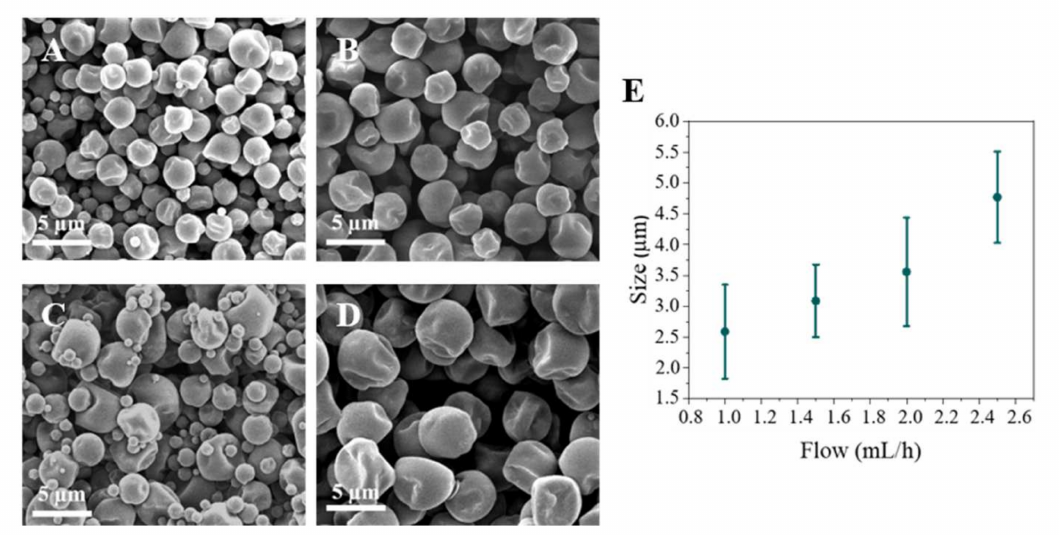
Figure 1. Particle size in function of flow (mL/h) at 10% w / w concentration with chloroform as solvent: ( A ) 1 mL/h; ( B ) 1.5 mL/h; ( C ) 2 mL/h; ( D ) 2.5 mL/h; ( E ) Influence of flow on particle size distribution (mean ± SD, n =